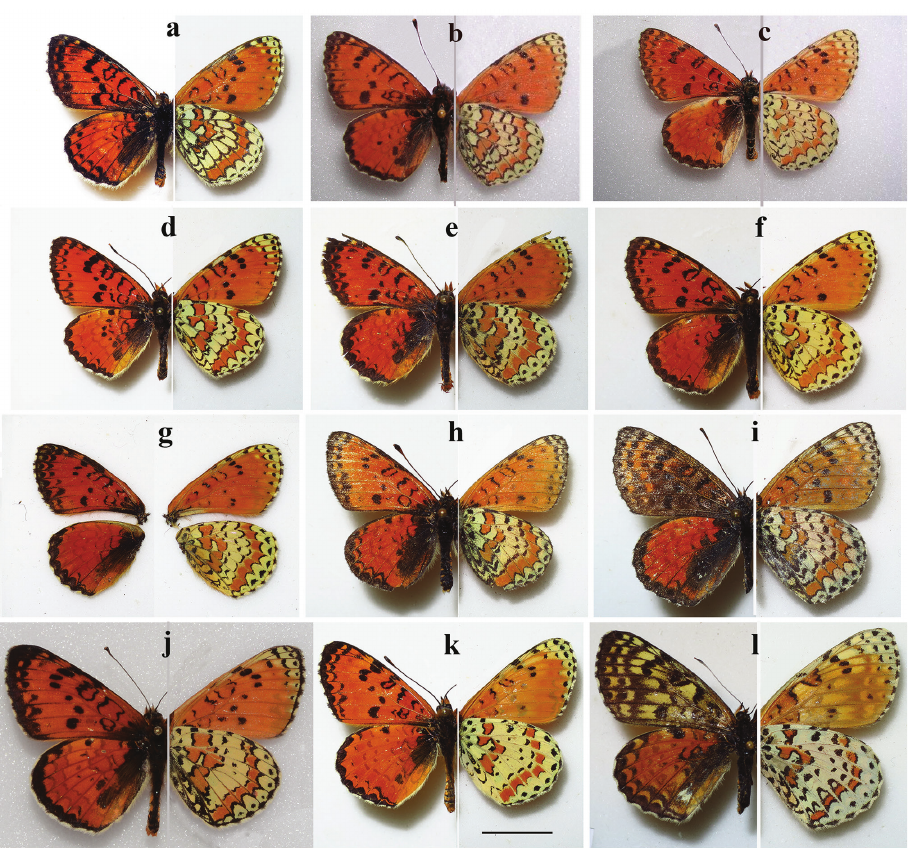
Figure 4. Butterflies of the Melitaea ala species complex a M. ala ala , male, BPALB179-16